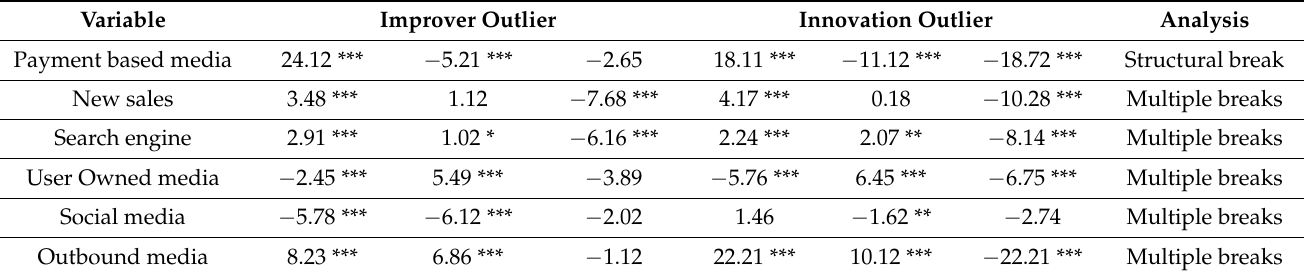
Table 3. Structural breaks along with Unit root on model